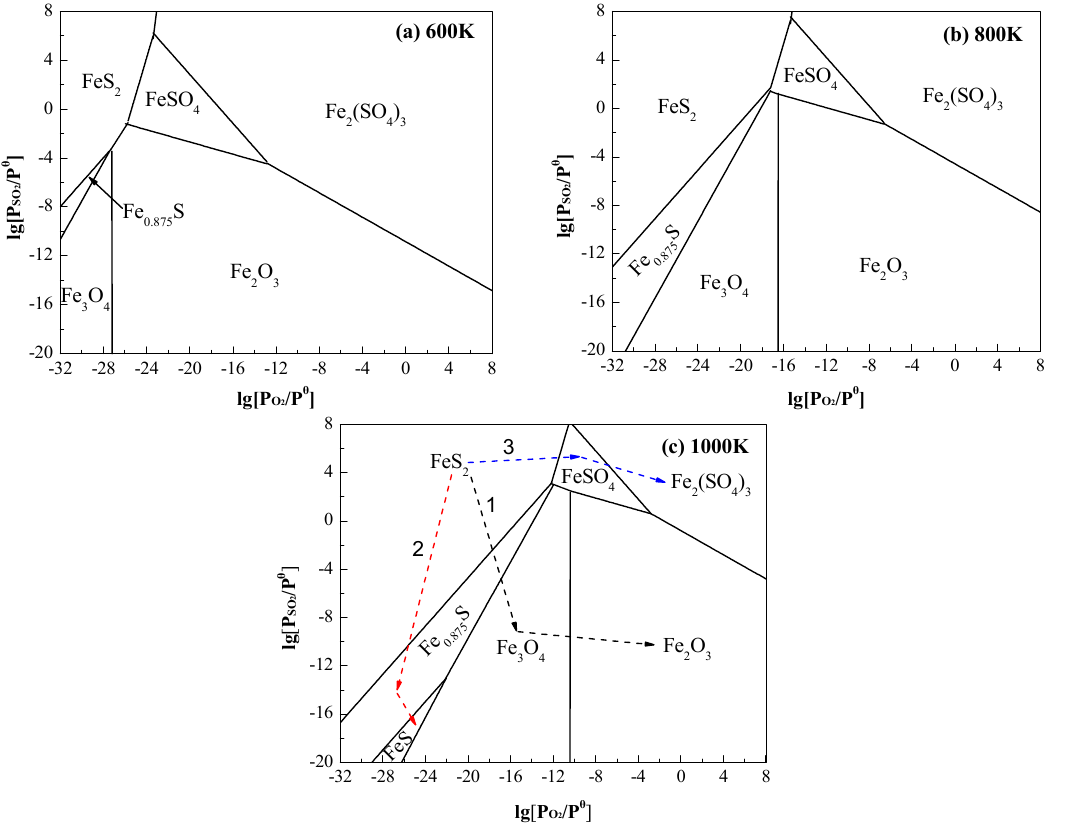
Figure 3. Isothermal predominance area of the Fe–S–O system as a function of lg[P SO 2 /P θ ] and lg[P O 2 /P θ ] at a temperature of ( a ) 600 K, ( b ) 800 K and ( c ) 1000 K.